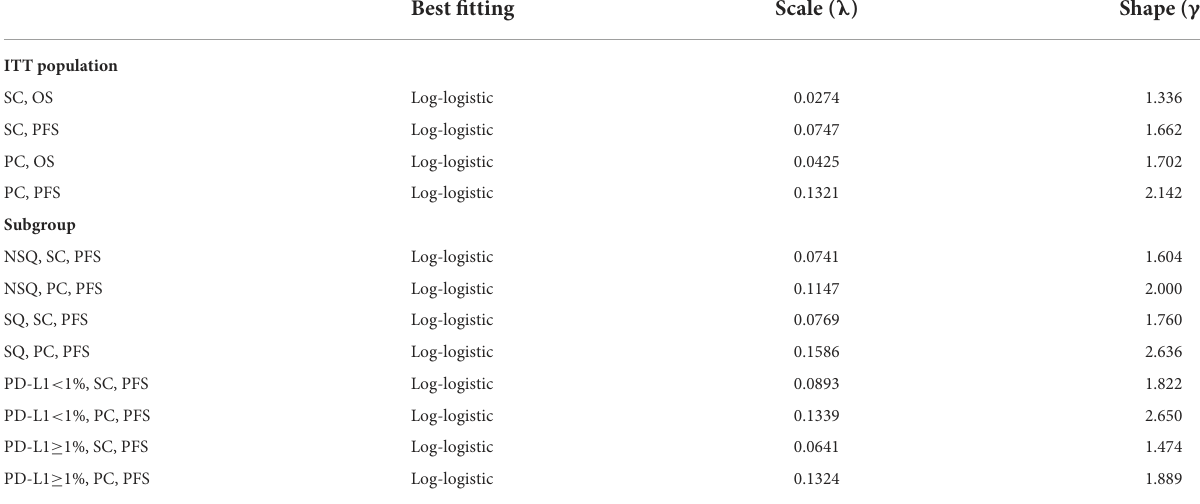
TABLE 1 Best fit and the values of the parameters.